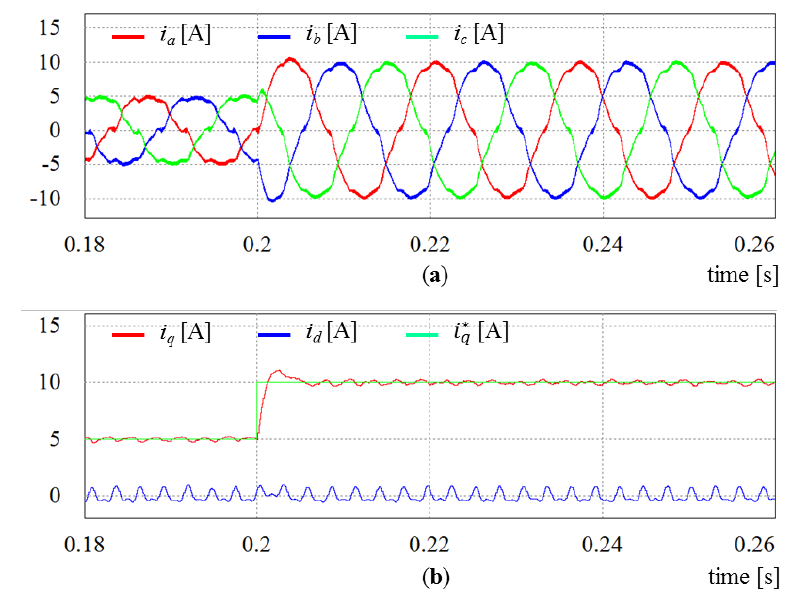
Figure 15. Transient responses of the conventional PI decoupling current controller under the distorted grid voltages: ( a ) phase-currents; and ( b ) q- axis and d- axis currents.